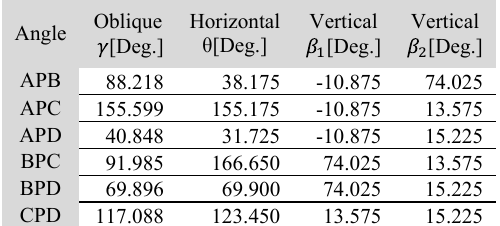
Table 2. Derived angles of the first test.